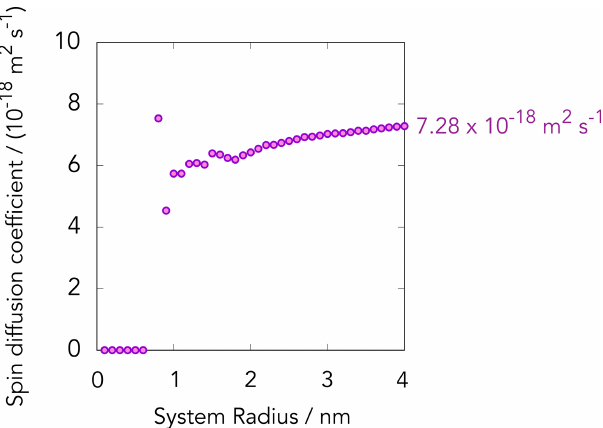
Figure 8. 13 C spin-diffusion coefficients calculated for diamond crystal using the Lowe–Gade formula (Eq. 7) by taking account of naturally abundant 13 C sites within spherical regions with various radii; 750 13 C sites are involved within the sphere with a radius of